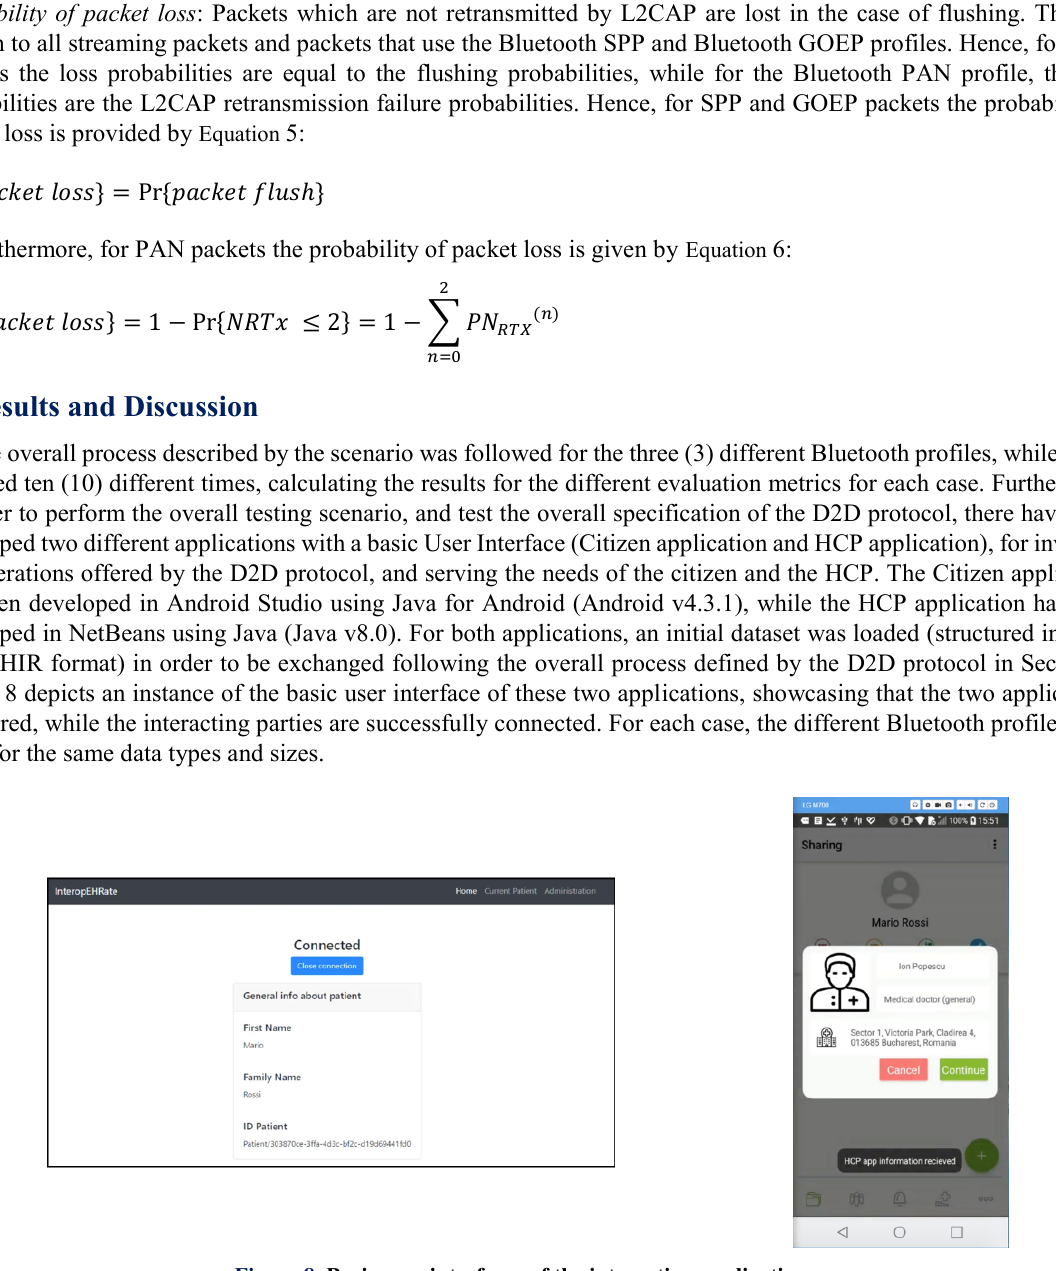
Figure 8. Basic user interfaces of the interacting applications.